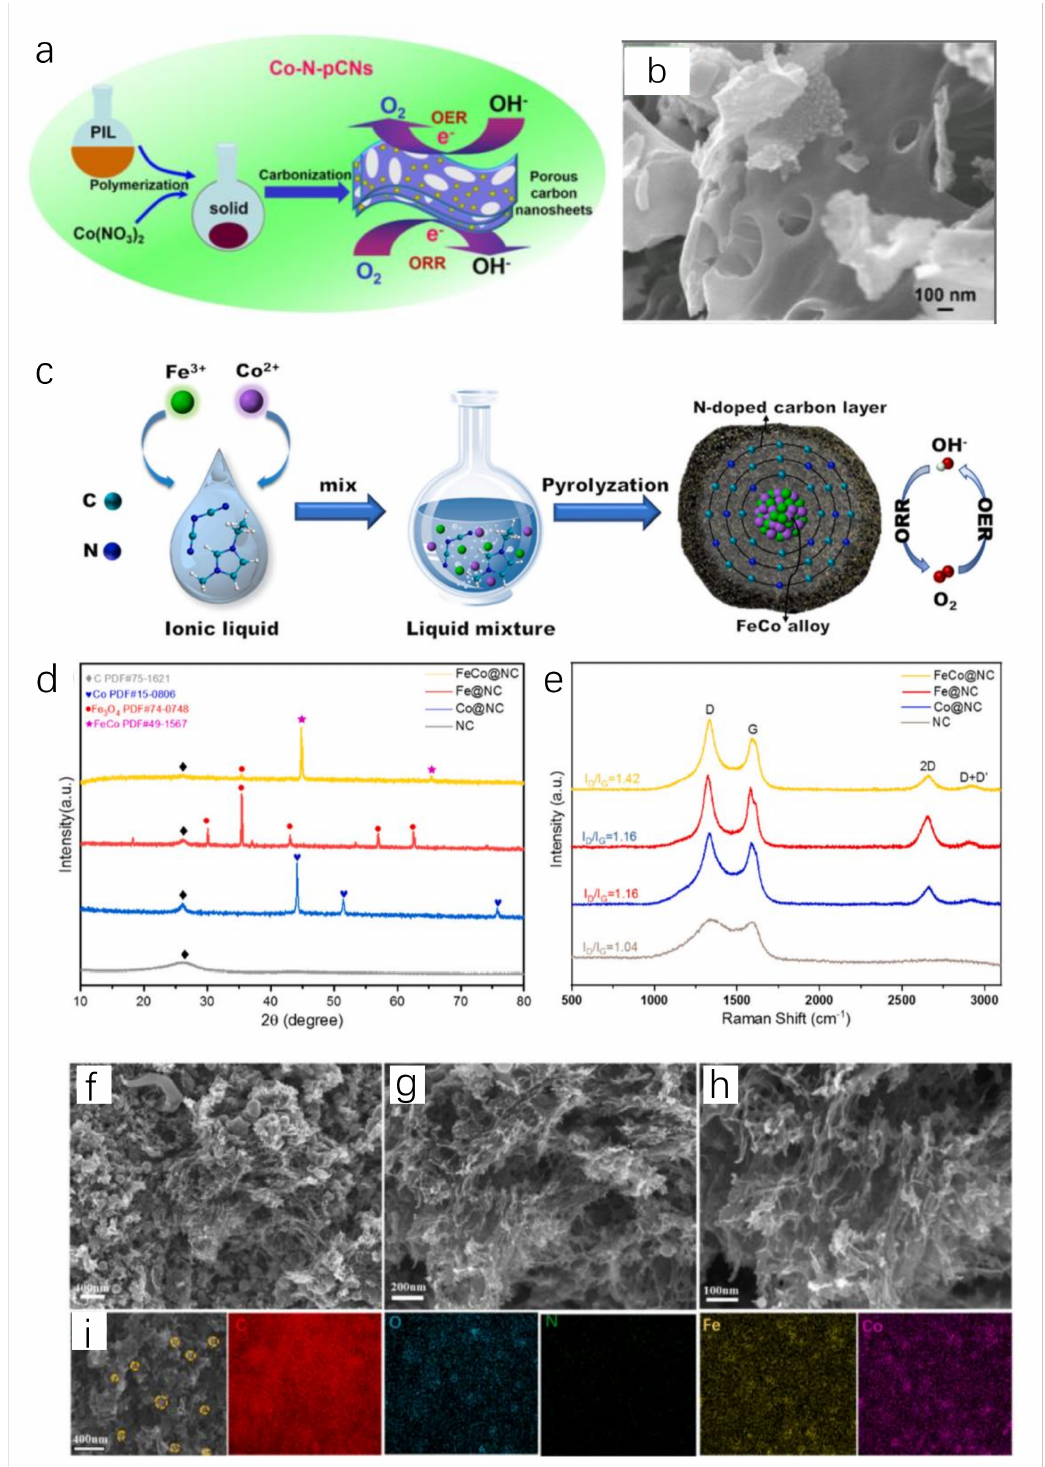
Figure 4. Schematic illustration for the fabrication process of 2D Co-N-C nanosheets ( a ), SEM image of 2D Co − N − C nanosheets ( b ). Reprinted with permission from ref. [91], copyright 2017 wiley. Schematic illustration for the fabrication process of FeCo@NC ( c ), XRD patterns ( ♦ (gray), (blue), • (red), (cid:70) (pink) on behalf of C, Co, Fe 3 O 4 , FeCo, respectively) ( d ) and Raman spectra ( e ) of FeCo@NC and control samples. SEM images ( f – h ) and EDS elemental mapping images ( i ) of FeCo@NC. Reprinted with permission from ref. [92], copyright 2022